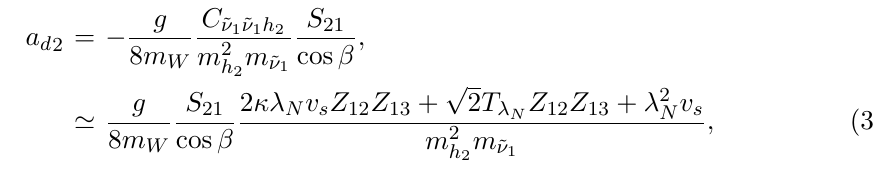
to predict large j a j and (cid:27) , and the parameter region preferred by the experiment is ~ (cid:23) 1 (cid:0) p d 1 . 0 : 15 and j T Y j . 100 GeV. This fact can be understood from eq. (2.30) by noting (cid:23) (cid:23)